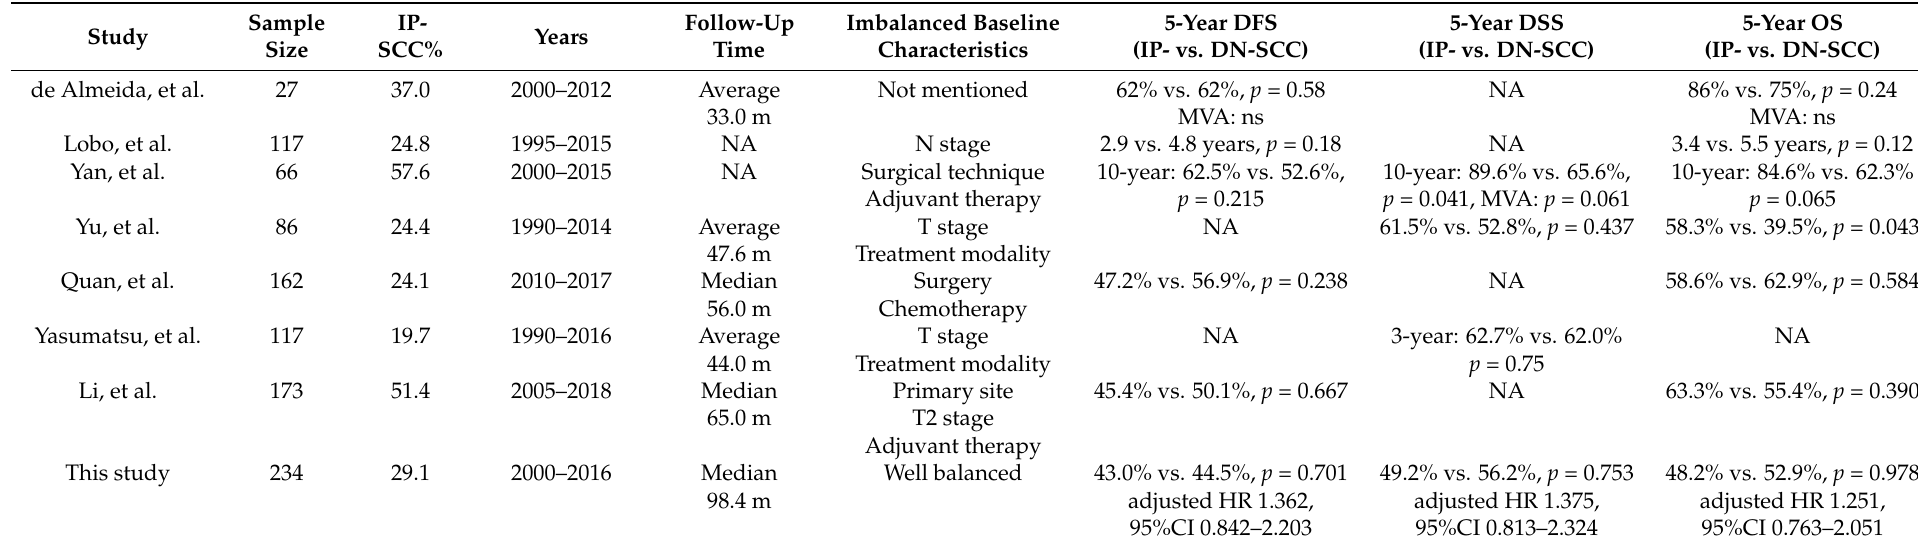
Table 3. Summary of studies comparing clinical outcomes of sinonasal IP-SCC and